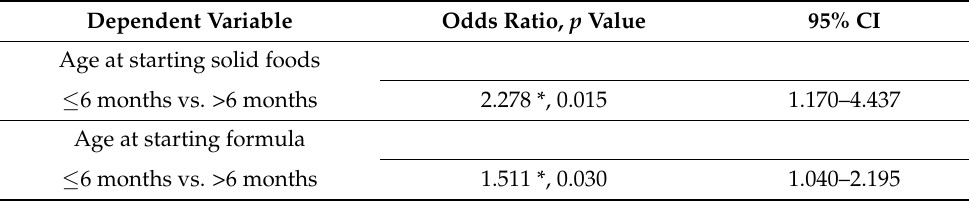
Table 2. Estimated odds ratios, 95% confidence intervals (CI) and p -value based on Wald Z statistic for the effect of overweight/obesity among 10-year-olds on odds of age at introduction to formula and age at introduction to solid foods, respectively, after controlling for maternal return to work following maternity leave, in Burj Hammoud,